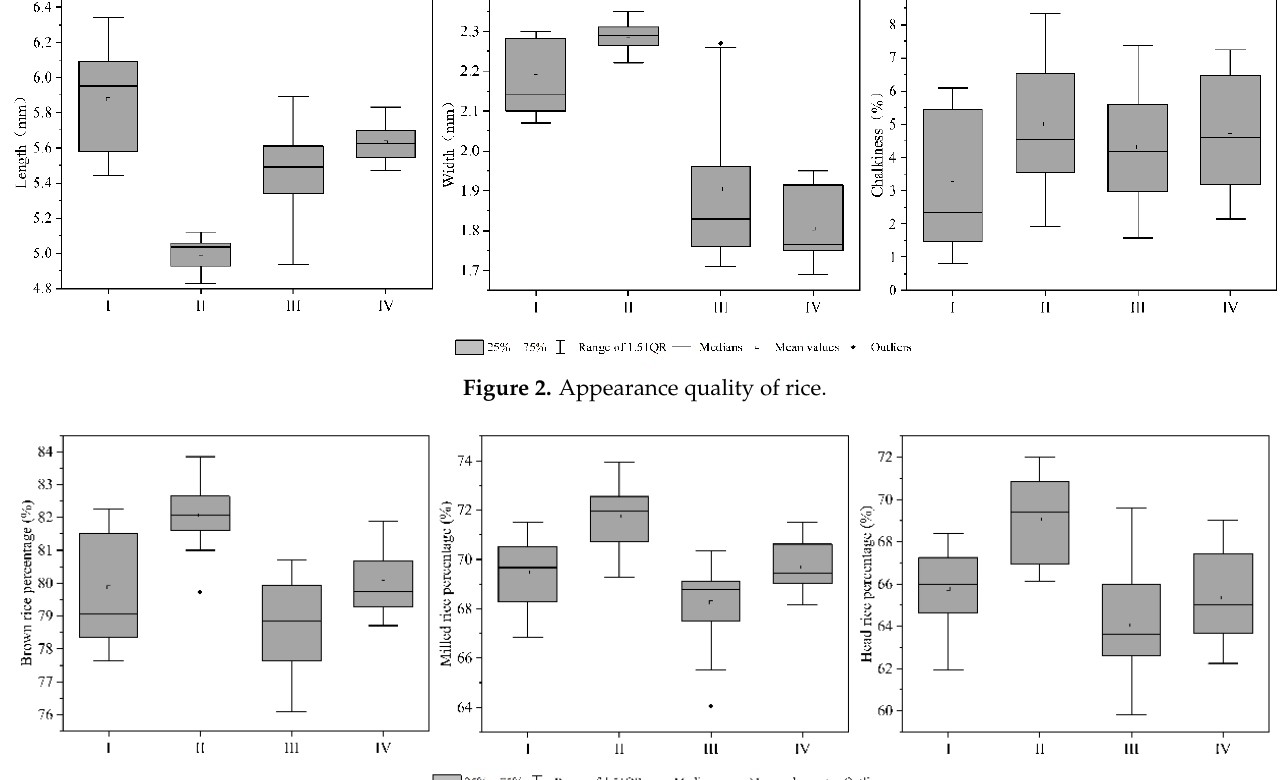
Figure 2. Appearance quality of rice.